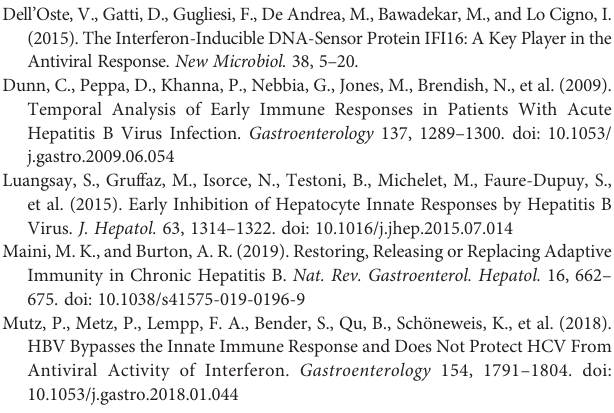
Supplementary Figure 1 | The subcellular distribution of IFI16 in immunocytes. IFI16wasbarelydetectedintheimmunocytes,whileitwassigni fi cantlyexpressedin the cytoplasm of immunocytes in some CHB patients (A) . In the PBMCs after two days of culture, IFI16 was signi fi cantly expressed in the nuclei and occasionally in the cytoplasm of healthy PBMCs (white arrows), while IFN- a 2b treatment promotes its nuclear expression (B) . Supplementary Figure 2 | The expression of IFI16 in liver tissues of patients with chronic HBV infection. CK18 was used to indicate the marker of the hepatocyte (green arrow). As shown in the representative fi gures, IFI16 was negative in the hepatocytes, while aggregated (A) or scattered (B) IFI16-positive cells were detected in the in fl ammatory areas in the liver tissues of CHB patients. The white arrows indicated the in fl ammatory areas with aggregation of in fl ammatory